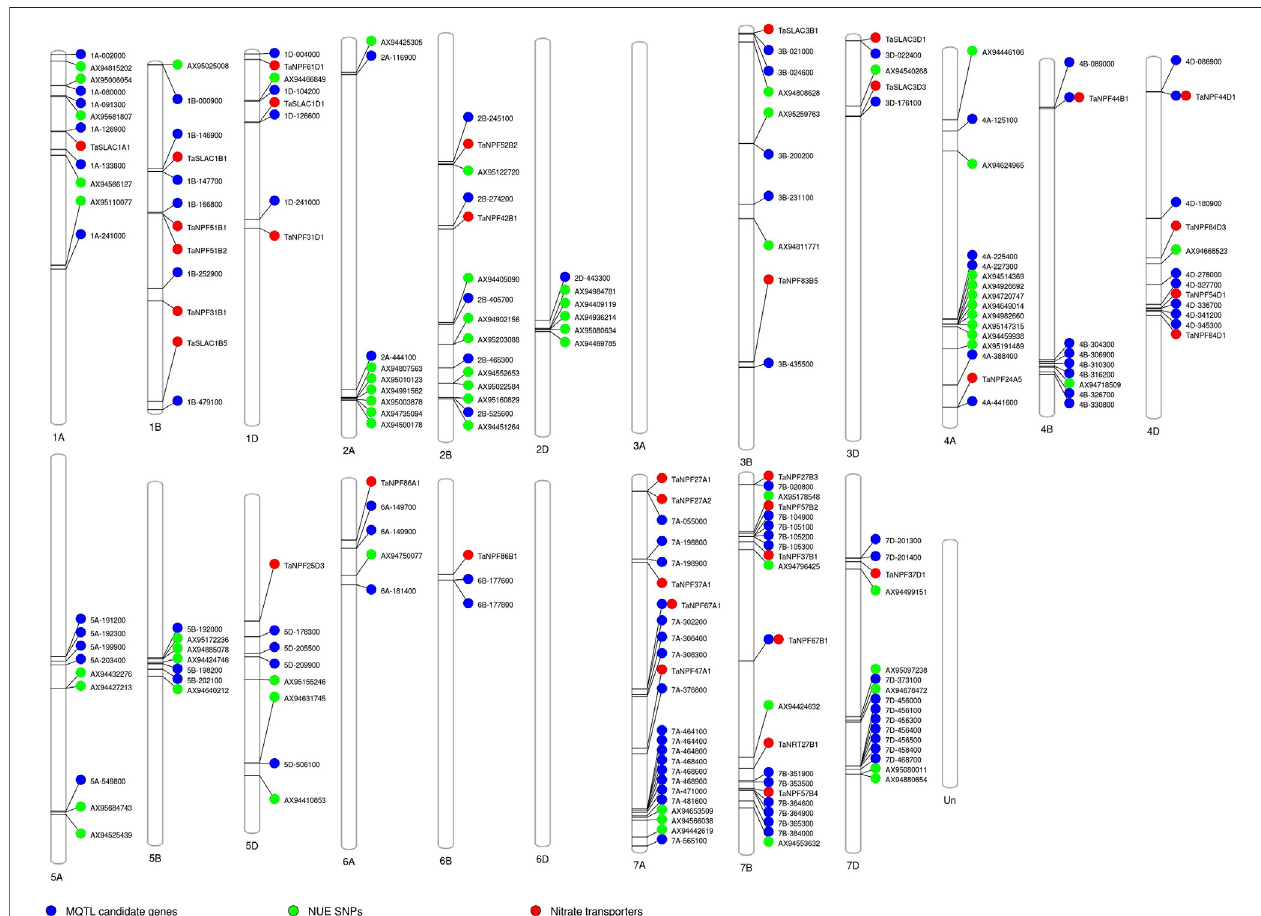
FIGURE 6 | Schematic representation of the distribution of previously reported single nucleotide polymorphism (SNP) associated with traits of interest, candidate genes reported in the present study, and the nitrate transporter along the 21 chromosomes of wheat. The chromosome map showing the candidate genes reported in the present study in the MQTL gene based on the synteny and their co-location with the previously reported single nucleotide polymorphism (SNP) associated with different nitrogen use ef fi ciency (NUE) – related trait, root traits, yield, and yield-related traits (Sandhu et al., 2021), and the nitrate transporter reported in wheat (Kumar et al., 2021). The numbers below each rice chromosome indicate chromosome numbers.